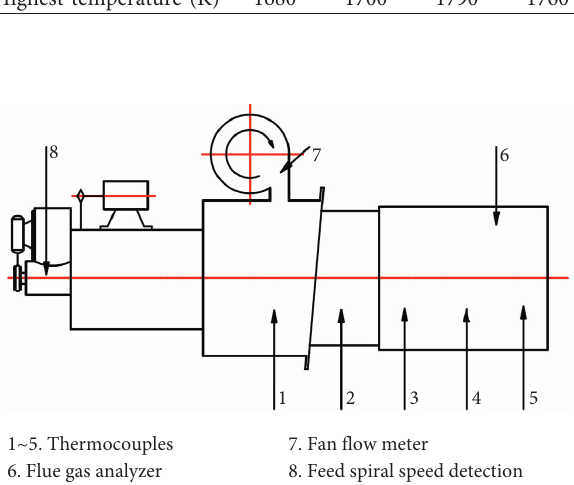
Figure 3: Schematic diagram of the thermocouple position in the burner test device.